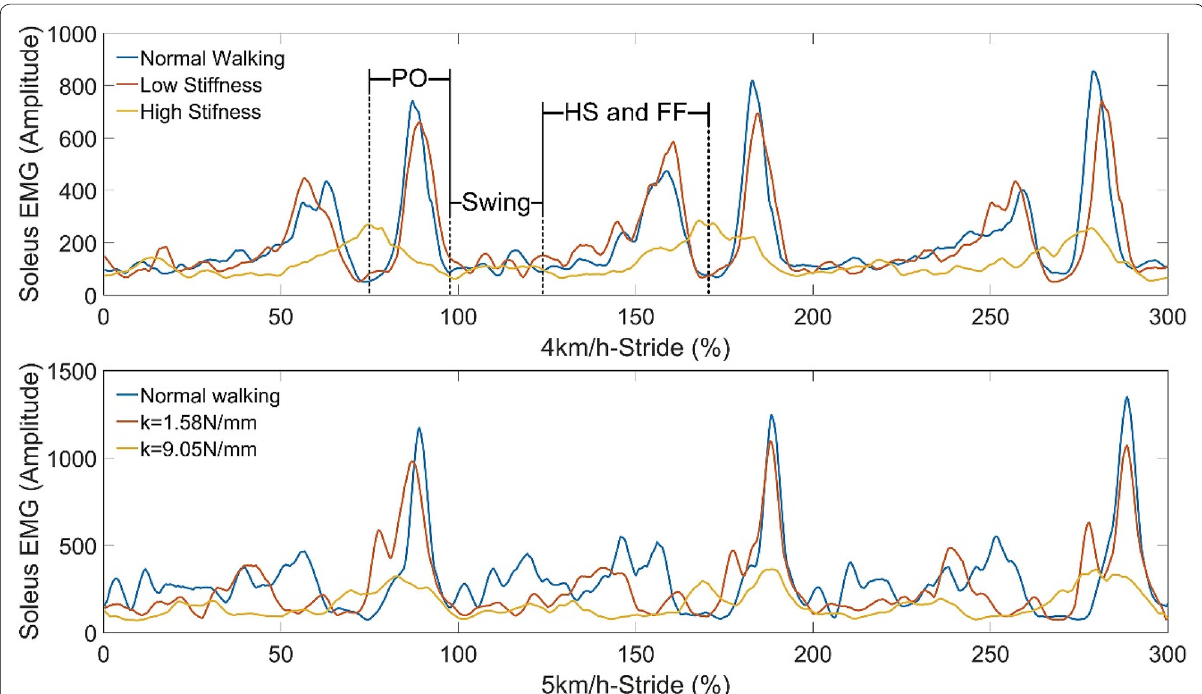
Figure 7 EMG signals of the soleus at different walking speeds and spring stiffness conditions